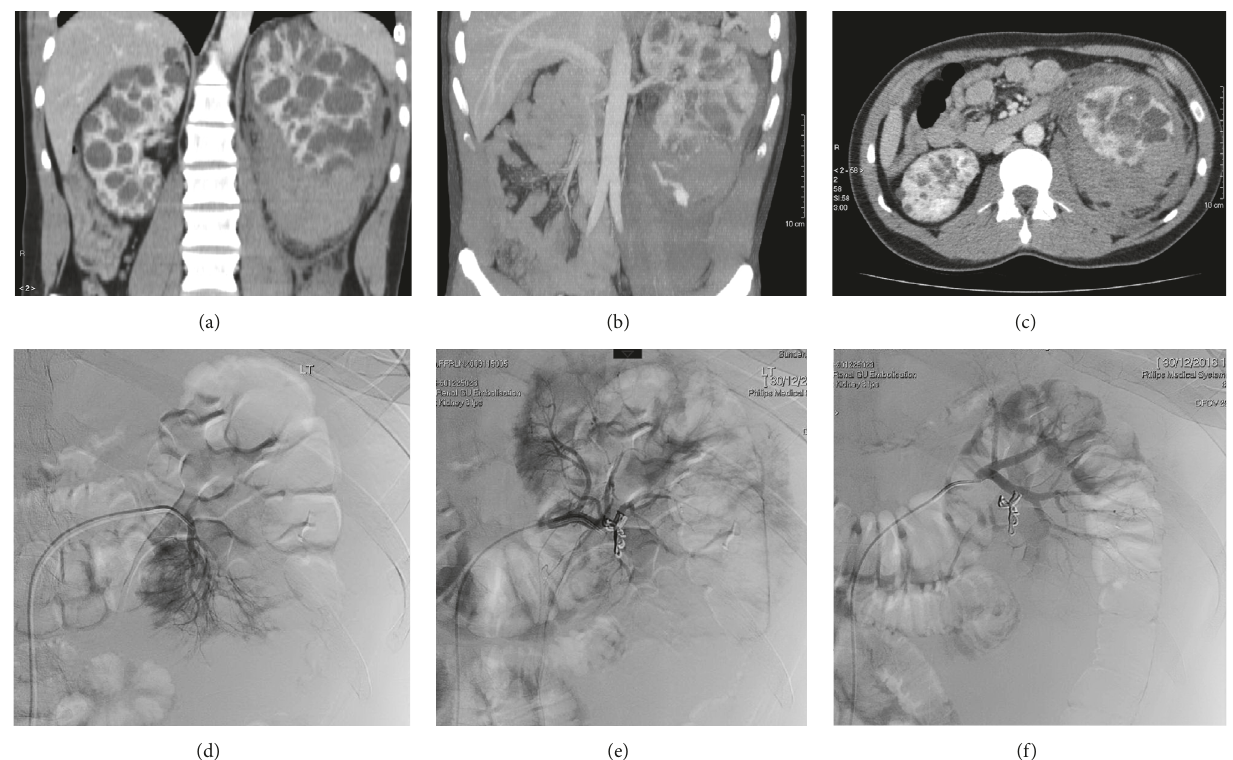
Figure 1: Computerised tomography (CT) of abdomen and left renal arteriogram and embolization of a patient with autosomal dominant polycystic kidney disease demonstrating large left renal retroperitoneal haemorrhage . Sagittal views (a and b) and (c) axial view of contrast enhanced CT abdomen showing bilateral polycystic kidneys with evidence of large volume haemorrhage which surrounds the left kidney and extends into the retroperitoneal space. Super-selective angiogram of the left renal artery lower polar segmental branch showing an extravasation into the lower polar renal cyst (d) and final, postembolization angiogram confirming satisfactory exclusion of the source of bleed (e and